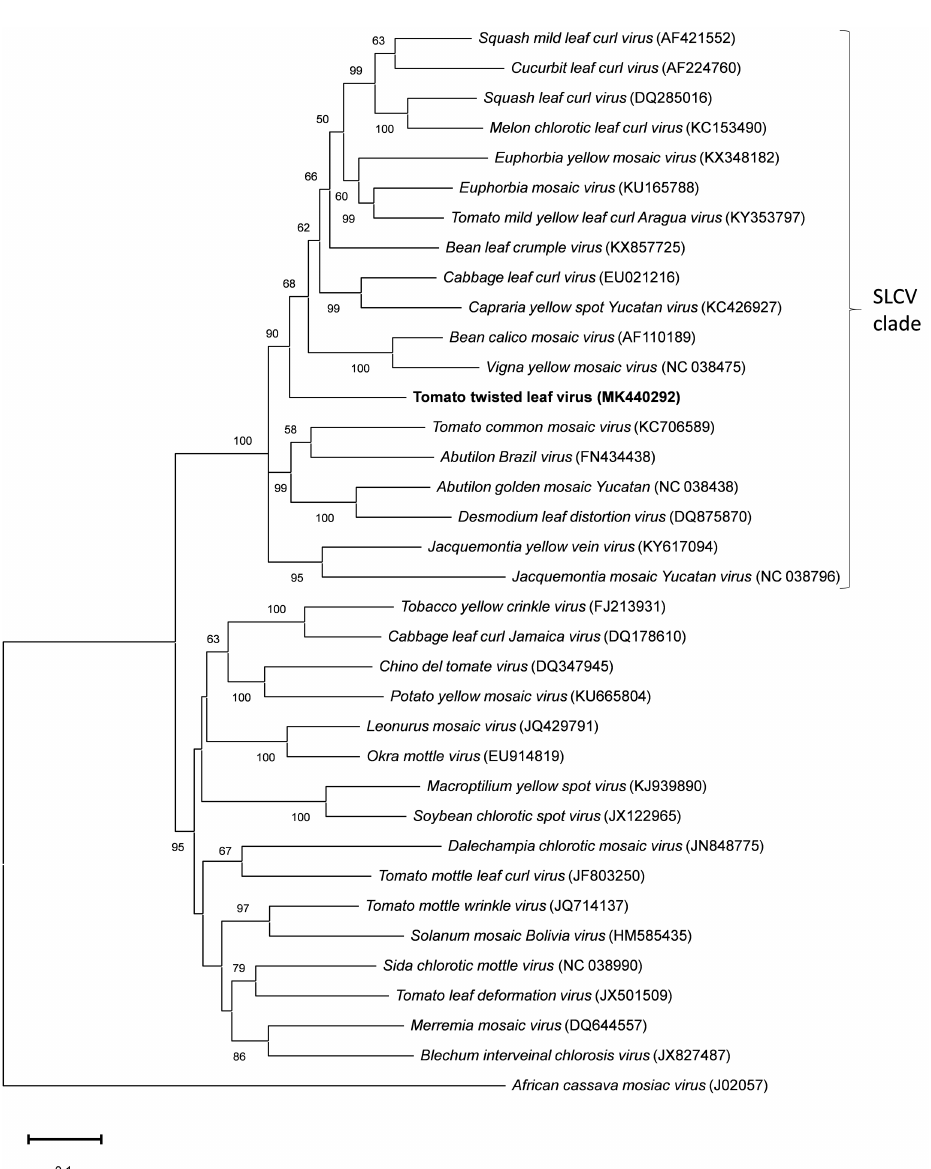
Figure 3. Phylogenetic relationships between the full-length DNA sequence of the novel begomovirus Tomato twisted leaf virus (highlighted in bold) and those of related begomoviruses. The phylogenetic tree is based on the Maximum likelihood method using GTR+G as a nucleotide substitution model. Bootstrap values (500 iterations) above 50% are indicated for each node. African cassava mosaic virus (ACMV) was used as an outgroup. GenBank accession numbers are indicated in brackets.